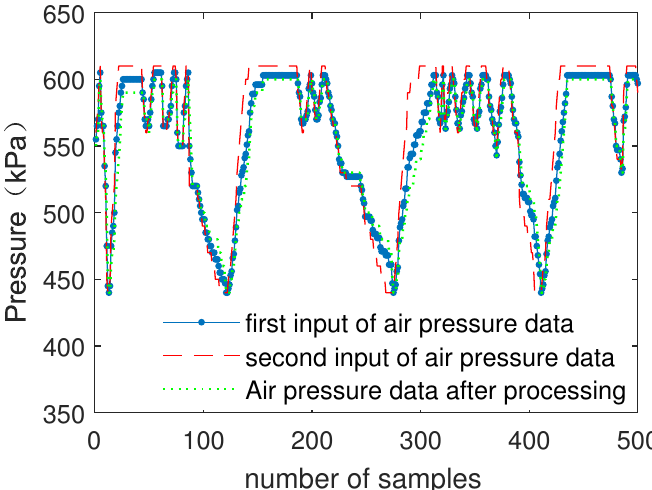
Figure 12. The comparison of air pressure data and data